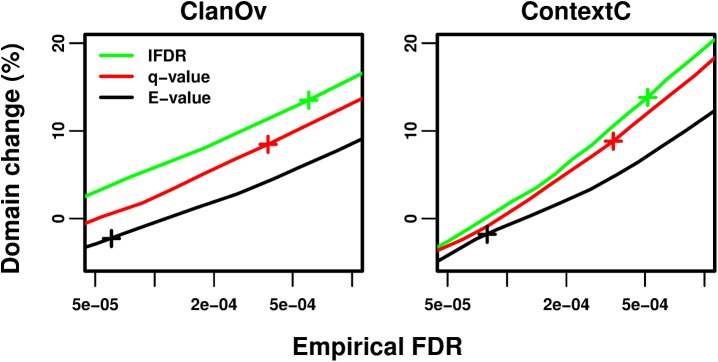
Domain change while controlling empirical FDRs, restricted to families with as-expected noise.This figure is exactly like Fig 3 except that only families with “as-expected noise” are used in the benchmarks. See Fig 3.